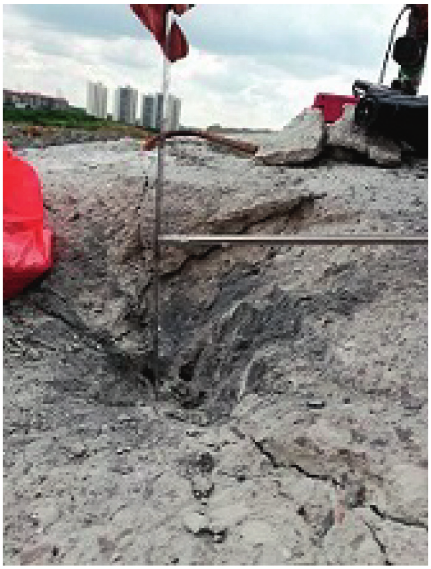
Figure 6: Cutting depth measurement. Table 5: Error analysis table of cutting depth fitting